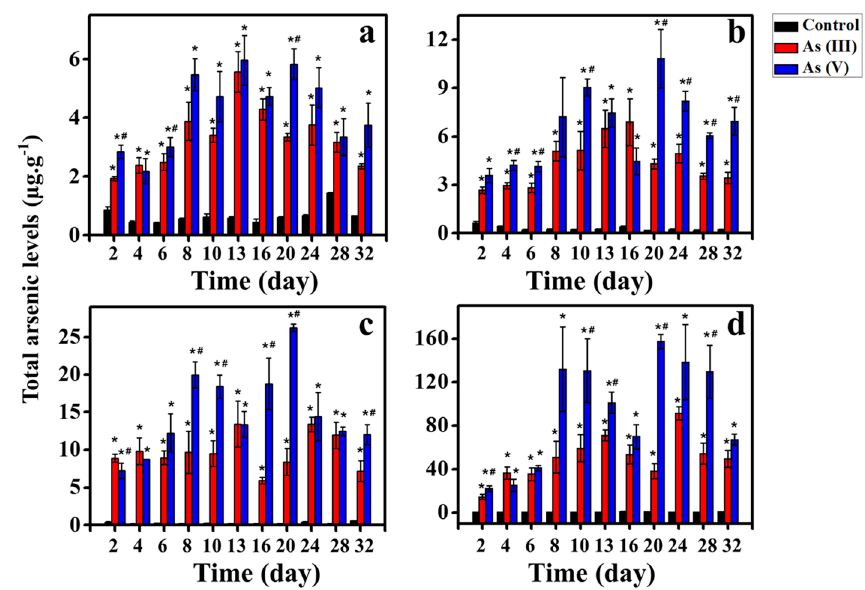
Figure 2. The time-course of total arsenic concentrations in Tilapia: ( a ) muscle; ( b ) gill; ( c ) liver; and ( d ) GI. Asterisk (*) indicates significant differences between total As concentration in experimental and control groups ( p < 0.05), while hash (#) represents significant differences between total As concentration in experimental As(III) groups and As(V) groups ( p < 0.05).